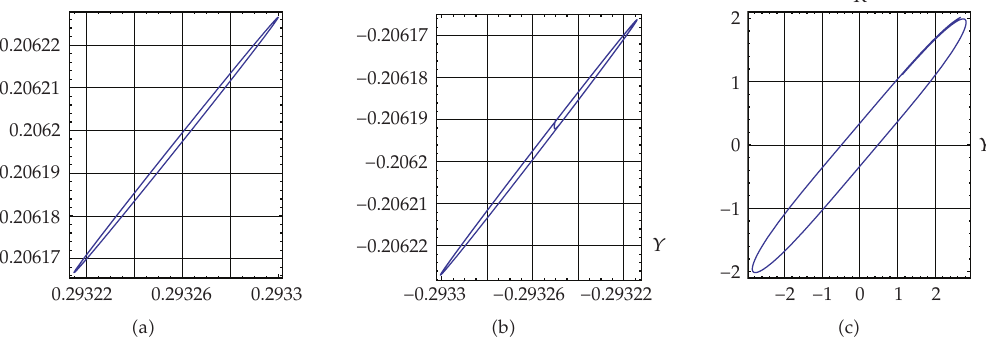
Figure 3: Three limit (cid:5) two small and one large (cid:6) cycles are generated when (cid:5) μ 1 ,μ 2 (cid:6) is in the region between (cid:5) H 2 and C